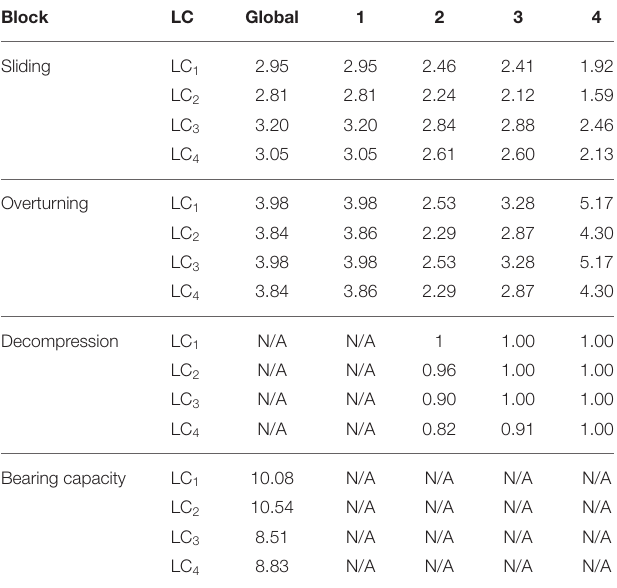
TABLE 4 | Safety factors for the constructability of the example block wall in a single stage.